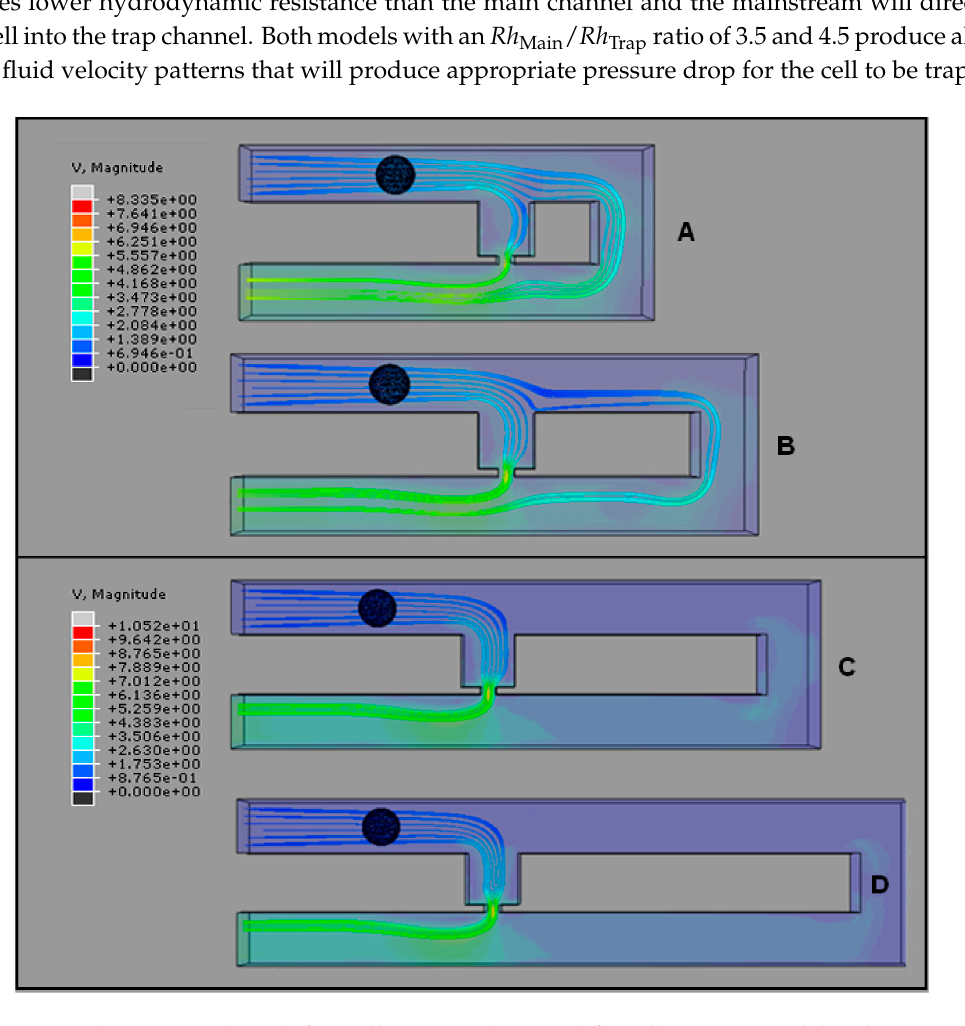
Figure 3. Velocity streamlines before cell trapping (top view) for cell trapping model with W Hole of 2 μ m for different Rh Main / Rh Trap ratios of ( A ) 1.5; ( B ) 2.5; ( C ) 3.5; and ( D ) 4.5. V represents the fluid’s velocity in μ ms − 1 .